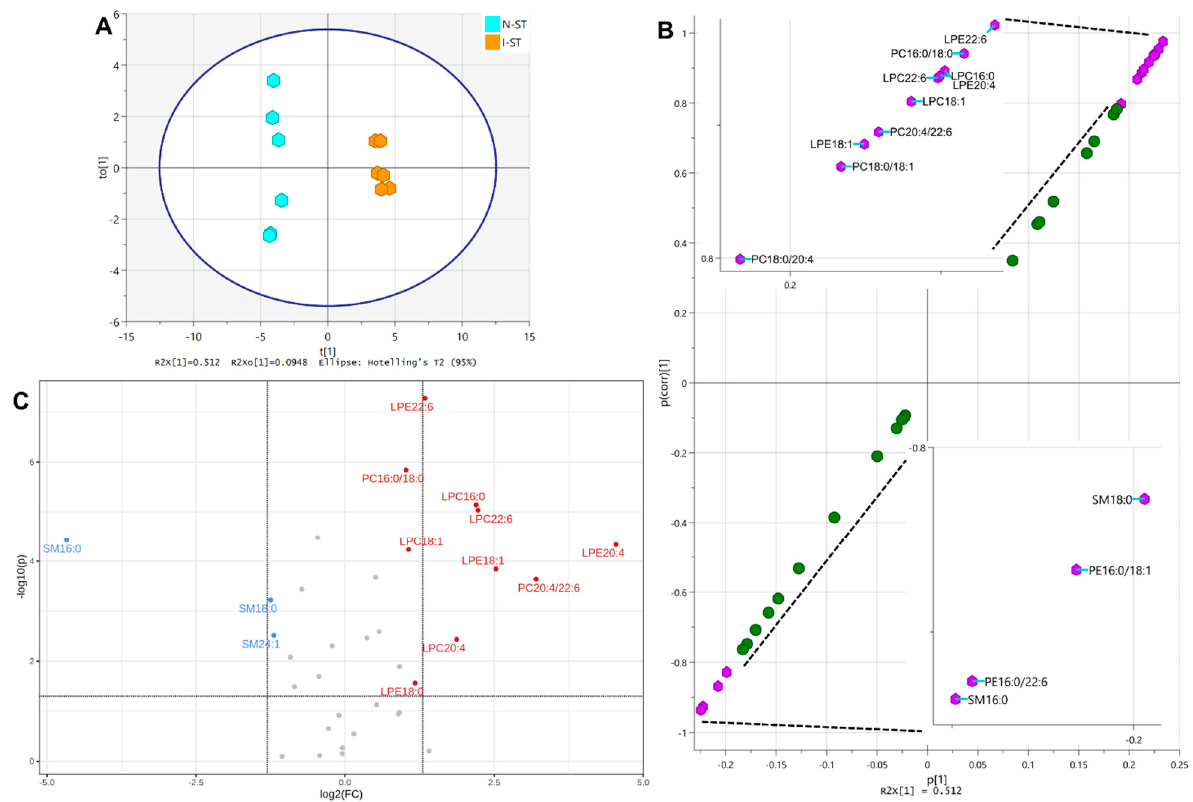
Figure 6. ( A ): The scatter plot of OPLS-DA on lipids in normal striatum (N-ST) and ischemic striatum (I-ST) of rat brains. ( B ): S-plot of OPLS-DA on lipids in N-ST and I-ST of rat brains. Lipid species with p(corr)[1] > 0.8 (upper-right purple hexagons and upper-left inset) or < − 0.8 (lower-left purple hexagons and lower-right inset) are identified. ( C ): Volcano plot analysis on lipids in N-ST and I-ST of rat brains. Lipids with − log10(p) > 1.301 and log2(FC) > 1 or < − 1 are identified. See Figure 3 and text for details. Table 5 listed the t-statistic, p value, and the FDR of lipids in I-ST that were statisti- Table 5. List of lipid species showing statistical significance ( p < 0.05) between I-ST and N-ST (N = 6 each, unpaired t -test), with the t-statistic, p value, − log(p), false discovery rate (FDR) of each listed lipid markers was 0.0119, and that from volcano-plot-identified lipid markers was 0.0602. lipid species, and the sum of FDR from all listed lipid species, (the FDR column), from S-plot of OPLS-DA identified markers, and from volcano-plot-identified markers. N-ST vs.